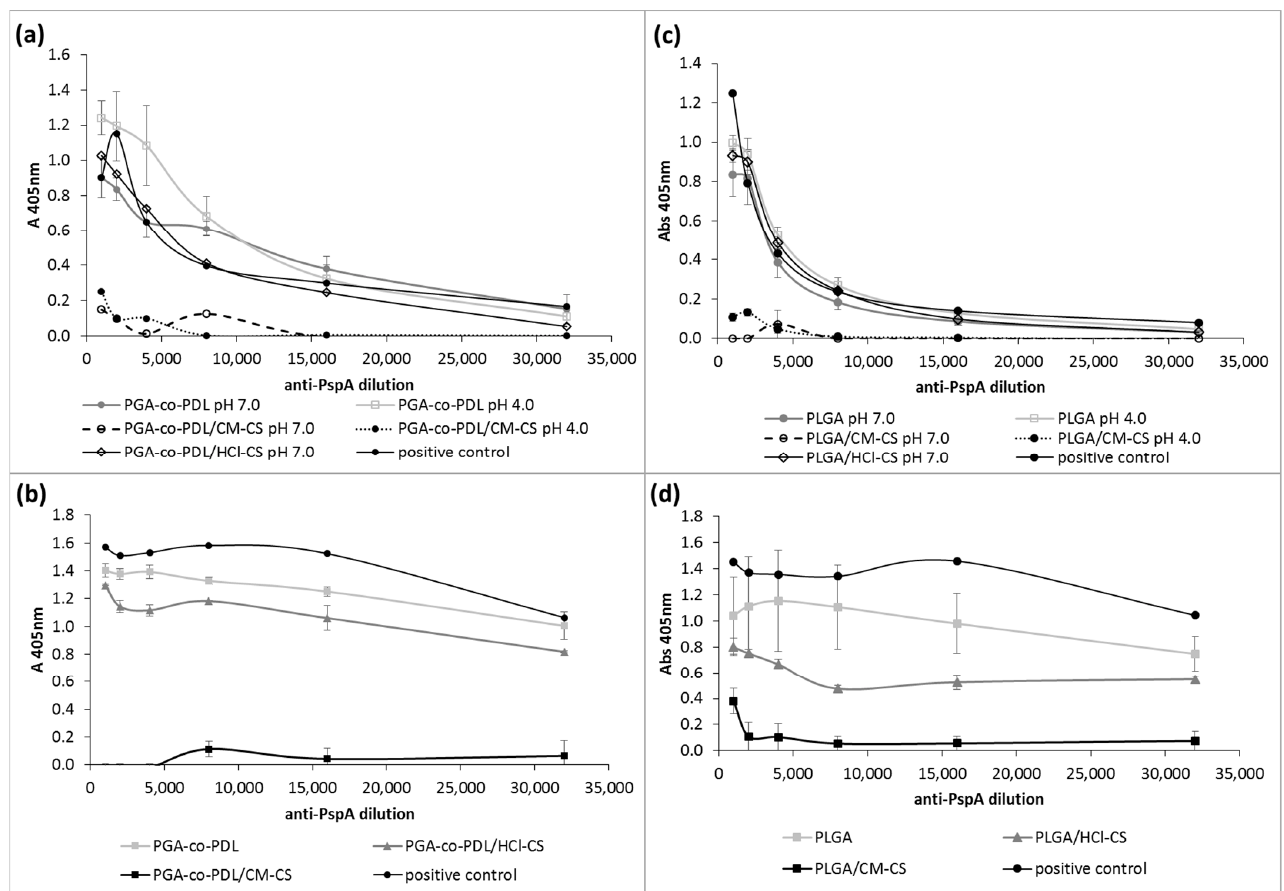
Figure 5. Recognition of PspA4Pro released from NPs by anti-PspA antibodies. ( a ) PGA-co-PDL and ( c ) PLGA NPs with or without chitosan prepared at pH 4.0 or 7.0 by o / w single emulsion with surface-adsorbed PspA4Pro. ( b ) PGA-co-PDL and ( d ) PLGA NPs prepared at pH 7.0 by w / o / w double emulsion with encapsulated PspA4Pro. Chitosan hydrochloride (HCl-CS) or